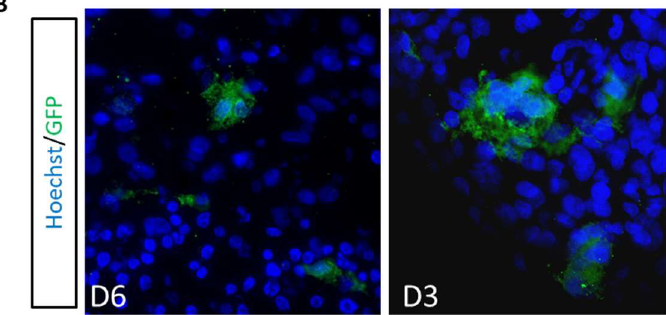
Figure 8. Microglia are the only HIV target cells. ( A ) Double immunostainings of 3D cerebral organoids (OH1.5) with GFP combined with IBA1 (microglia) at day 3 post-infection with NL4- 3Balgp160GFP. ( B ) Representative pictures of GFP+ multinucleated microglia (IBA1+) in 3D cerebral organoids at day 3 and day 6 post-infection with HIVbalGFP. All pictures were taken with a magnification of 40x.